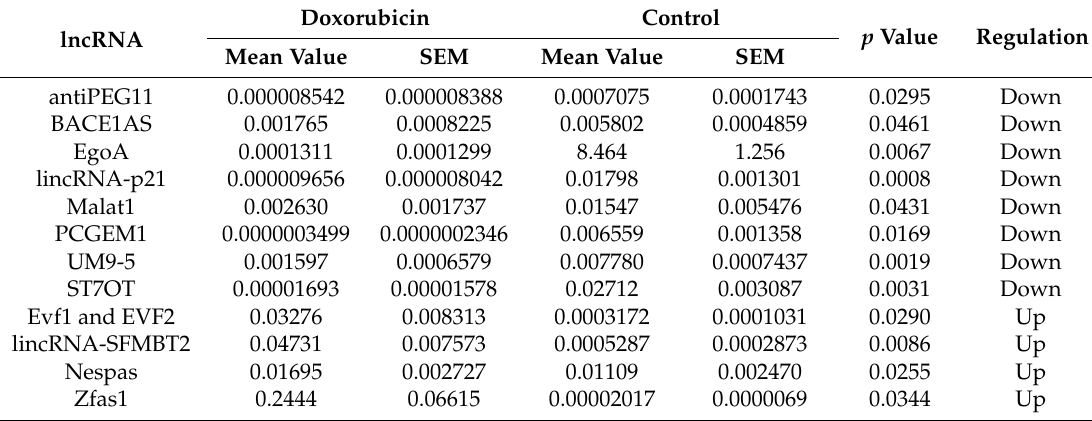
Table 6. Expression values of changed lncRNAs after exposure to